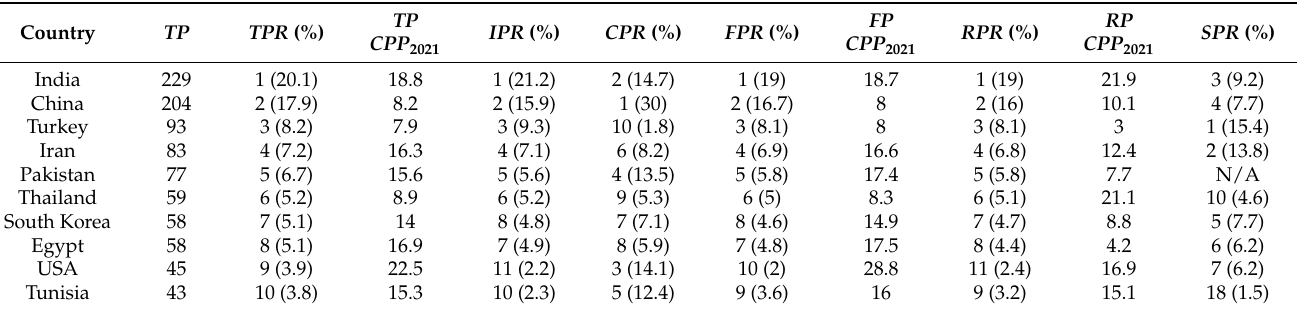
Because 5 publications (0.42% of 1183 articles) lacked the authors’ affiliation informa- tion in SCI-EXPANDED, they were not included in the analysis. Of the 1141 textile coloring with natural sources publications from 58 different nations, 178 (16%) were international collaborations, whereas 963 (84%) were single-country articles spanning 49 different coun- tries. Table 3 lists the top 10 industrialized nations. The top ten list of publications included six Asian nations, two African nations, one transcontinental nation, and one American nation. Italy, with 34 articles, was ranked 12th; the top productive country in Europe. Table 3. Top 10 productive